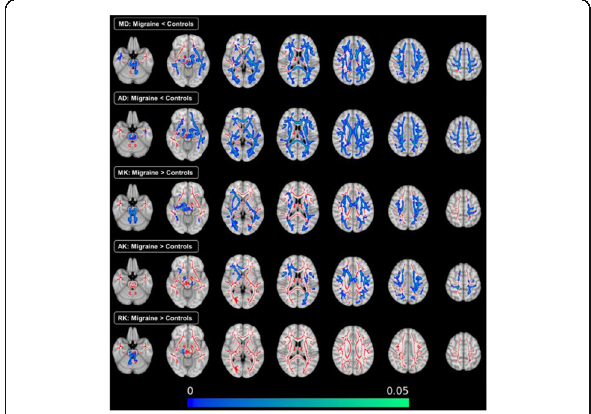
Fig. 1 (abstract P67). Results from voxelwise analysis of mean diffusivity (MD), axial diffusivity (AD), mean kurtosis (MK), axial kurtosis (AK) and radial kurtosis (RK) maps between controls and patients (p-value in blue-green); red represents mean FA skeleton